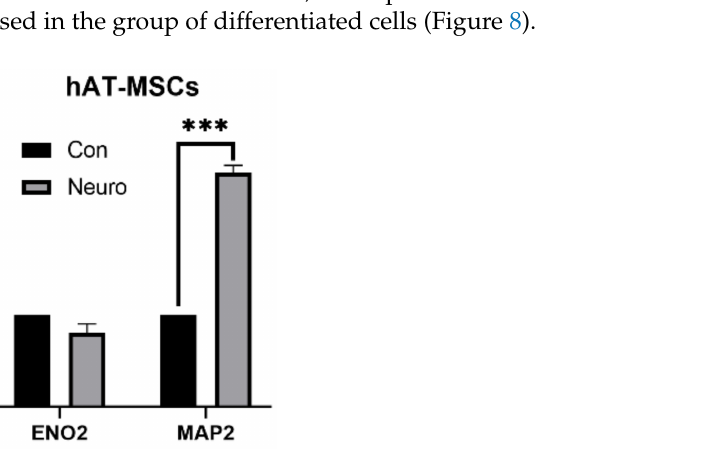
Figure 8. Expression of neural markers of human adipose tissue-derived mesenchymal stem cells (hAT-MSCs); *** p < 0.001; Con—control (non-induced sample), Neuro—neurodifferentiated sample; ENO2—neuron-specific enolase; MAP2—microtubule-associated protein